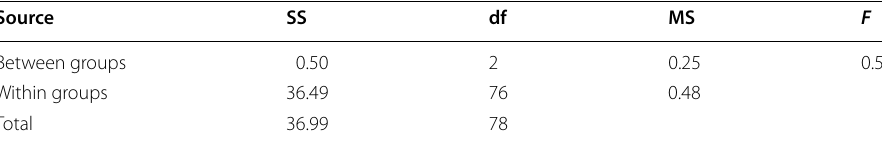
Table 6 The one-way ANOVA results of learner satisfaction scale Source SS df MS F Between groups 1.37 2 0.69 2.00 Within groups 26.04 76 0.34 Total 27.42